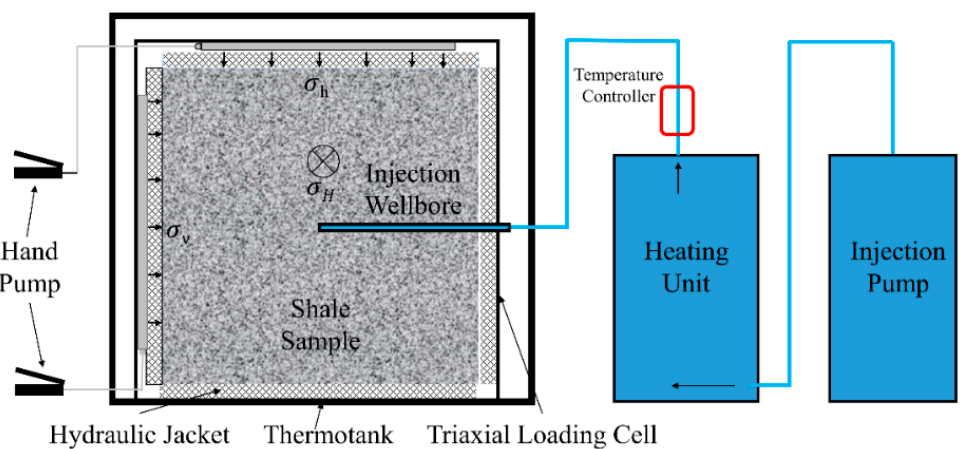
Figure 1. Schematic diagram showing apparatus for fracturing tests. The temperature of the whole system is 60 °C to make CO 2 into the supercritical state before injection into shale samples.